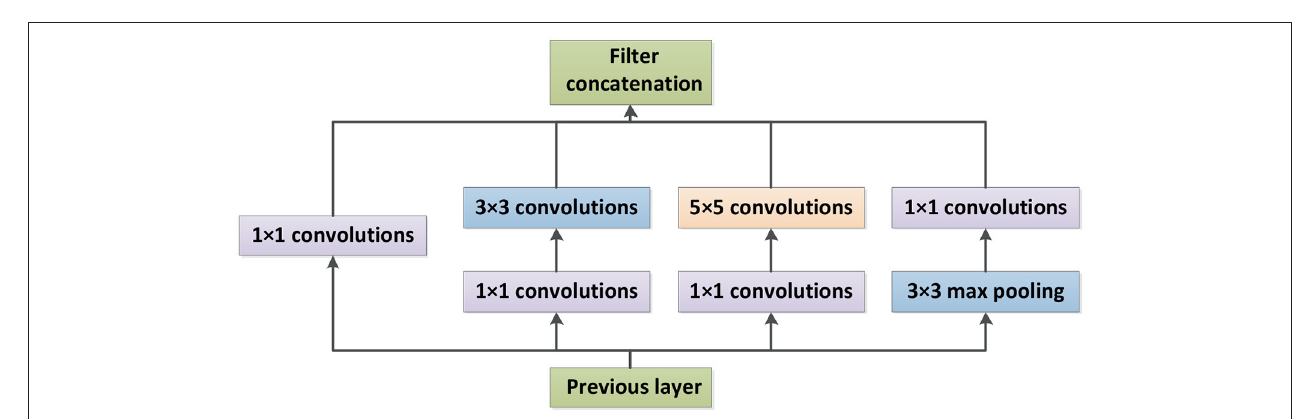
FIGURE 3 | Network structures of Inception-V4 and Inception-ResNet-V2.